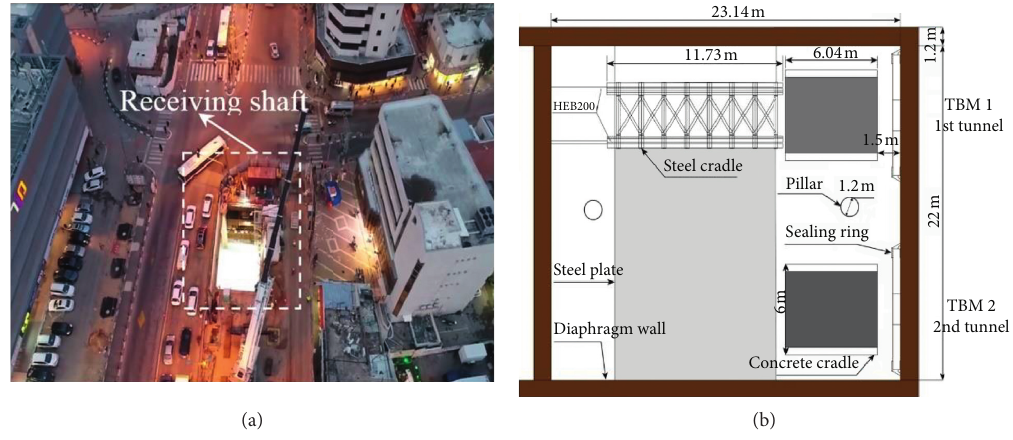
Figure 1: Illustrations of the receiving shaft: (a) the surrounding environment and (b) the design plan of the shaft.